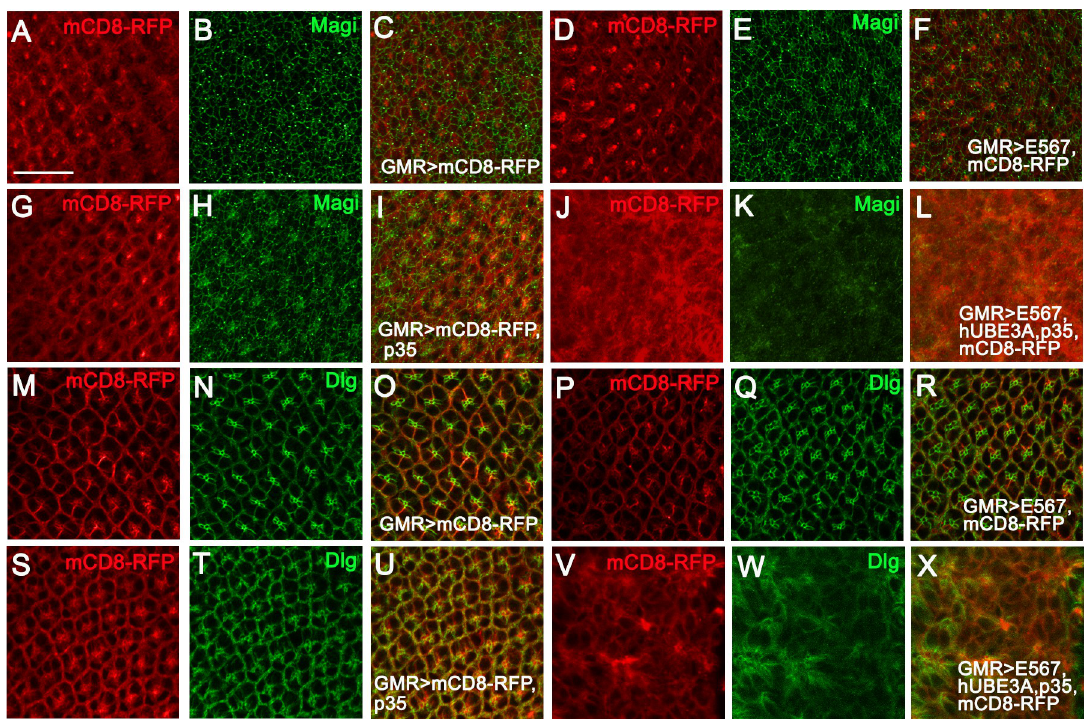
Fig 6. HPV16 E5, E6, E7 in conjunction with hUBE3A promote the degradation of PDZ domain proteins Magi and Dlg. Transgenes were expressed using the GMR-Gal4 in the third instar larval eye discs. mCD8RFP was used to mark the transgenes expression region and tissues were immunolabeled for PDZ domain proteins, Magi and Dlg. (A-C) Expression of mCD8RFP had no effect on Magi (B) . (D-F) Co-expression of mCD8RFP +E5, E6, E7 had no effect on Magi (E) . (G-I) Co-expression of mCD8RFP+p35 did not affect Magi level and localization (H) . (J-L) Co-expression of E5, E6, E7+hUBE3A+ mCD8RFP +p35 resulted in complete loss of Magi (K) . (M-O) Expression of mCD8RFP had no effect on Dlg (N) . (P-R) Co-expression of mCD8RFP +E5, E6, E7 had no effect on Dlg (Q) . (S-U) Co- expression of mCD8RFP+p35 did not affect Dlg level and localization (T) . (V-X) Co-expression of E5, E6, E7+hUBE3A+ mCD8RFP +p35 perturbed Dlg level and localization (W) but to lesser extent compared to Magi. Scale bar represents 100 μ